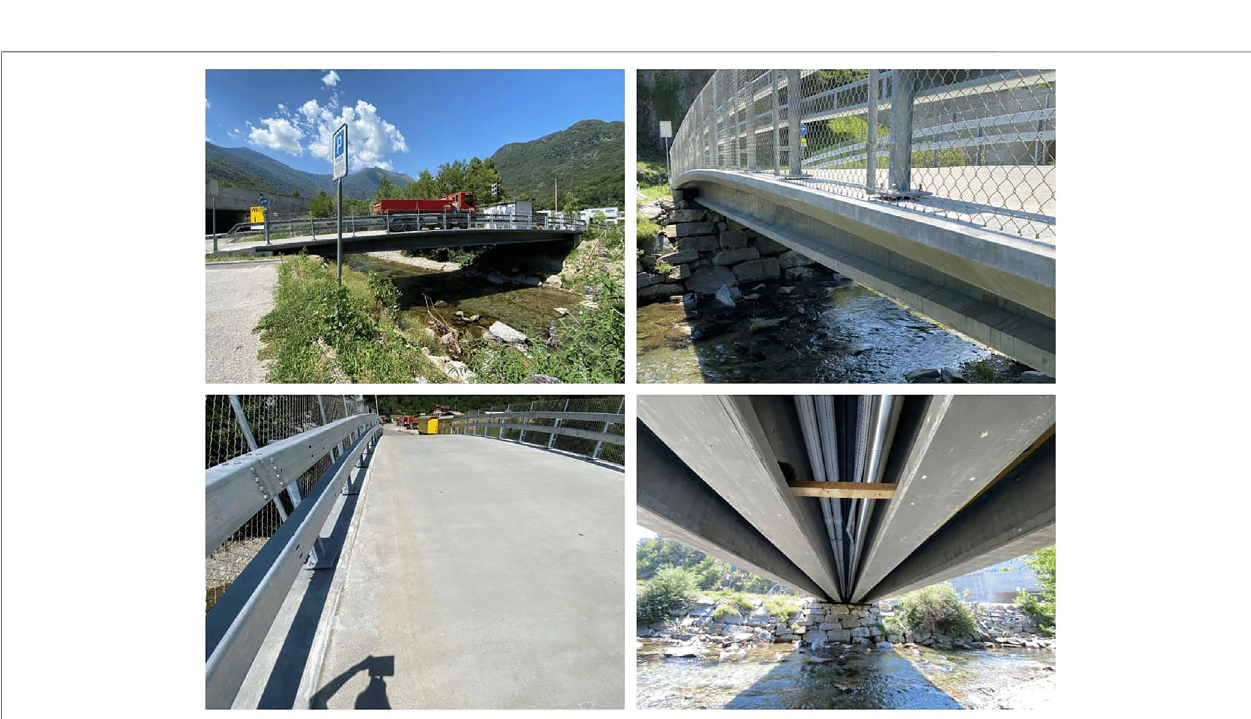
FIGURE 13 | Railway underpass Unterwalden (Sempach) with a structure in R-UHPRFRC resting on concrete abutments. (Photographs: E. Brühwiler).